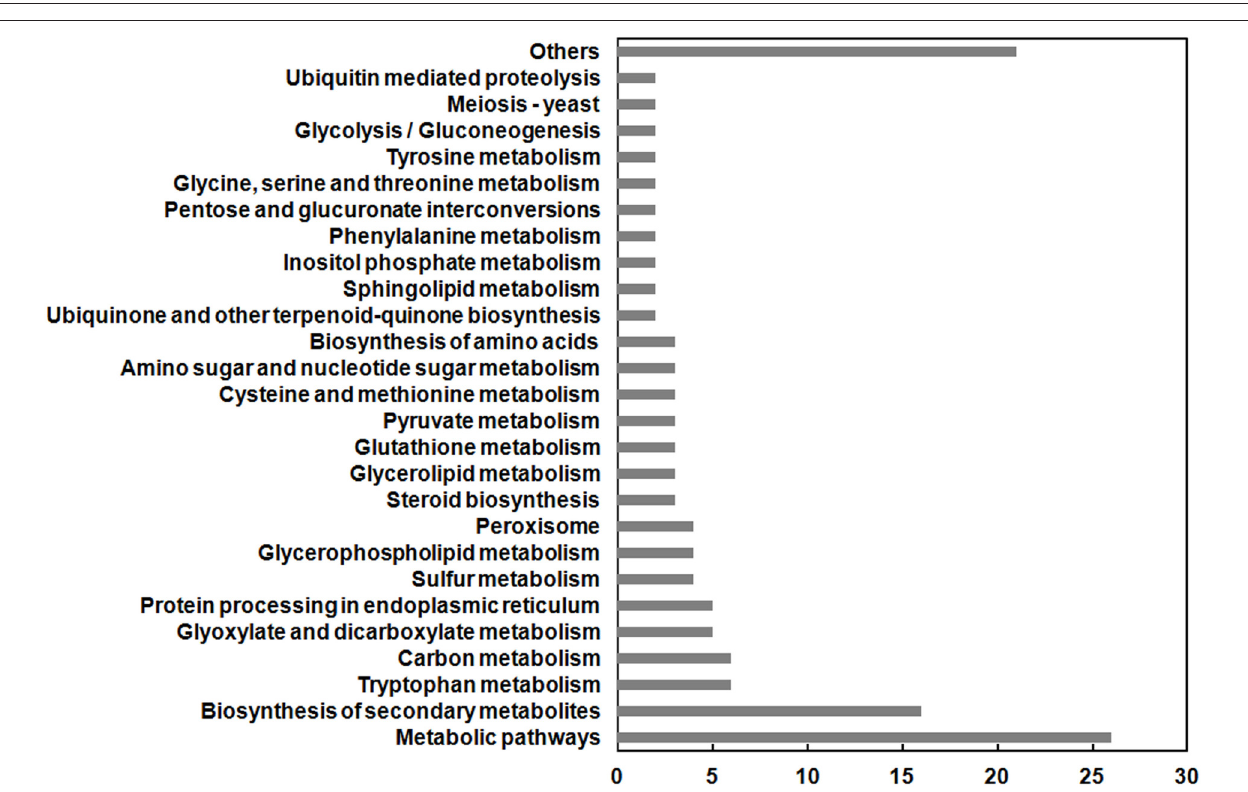
FIGURE 9 | Functional categories of gene significantly downregulated in 1 VdMcm1-5 . The histogram shows the enriched KEGG pathways. The values of x -axis represent the number of genes in each category.